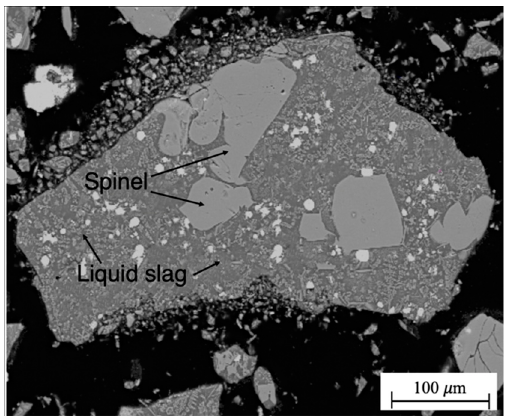
Figure 5. Scanning electron micrograph of liquid slags in equilibrium with spinel in industrial tests carried out with the addition of CaO and Al 2 O 3 .